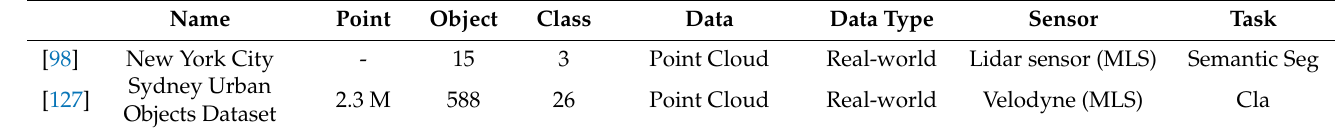
Table 3. Comparative summary of outdoor object-level